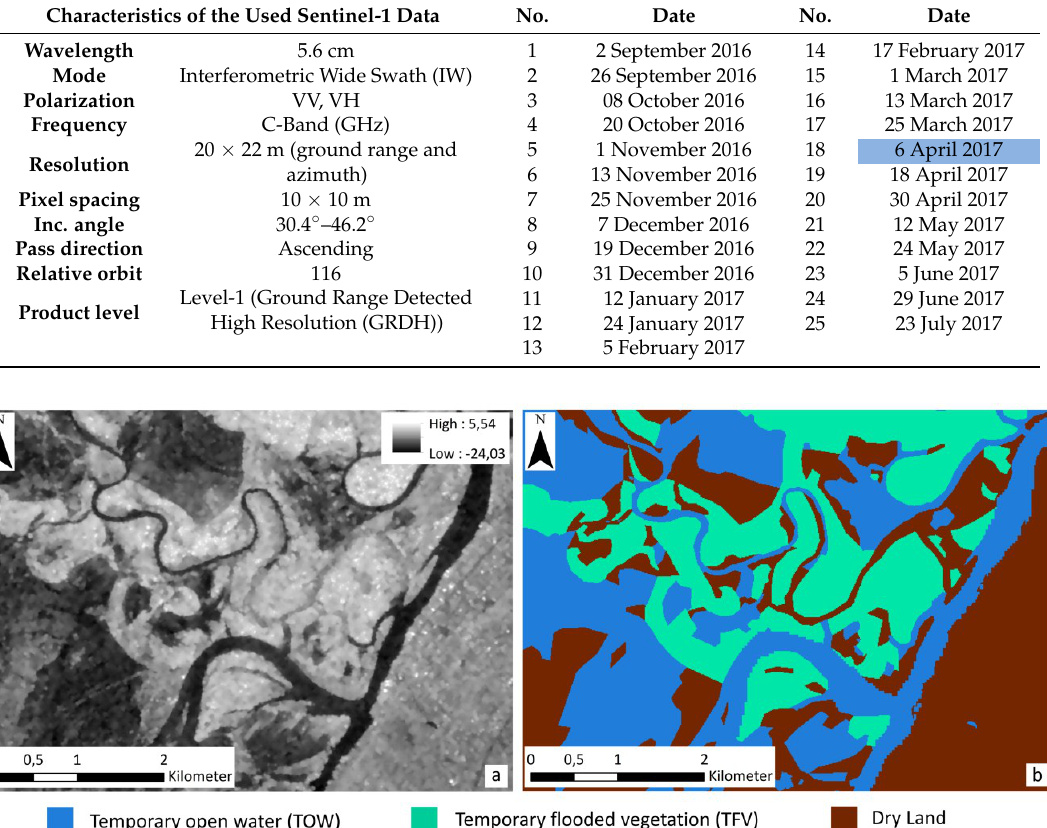
Table 1. Characteristics and acquisition dates of the used S-1 satellite data. S-1 scenes are acquired under the same orbit conditions. The scene acquired on 6 April 2017 was used within this study as flood event image.